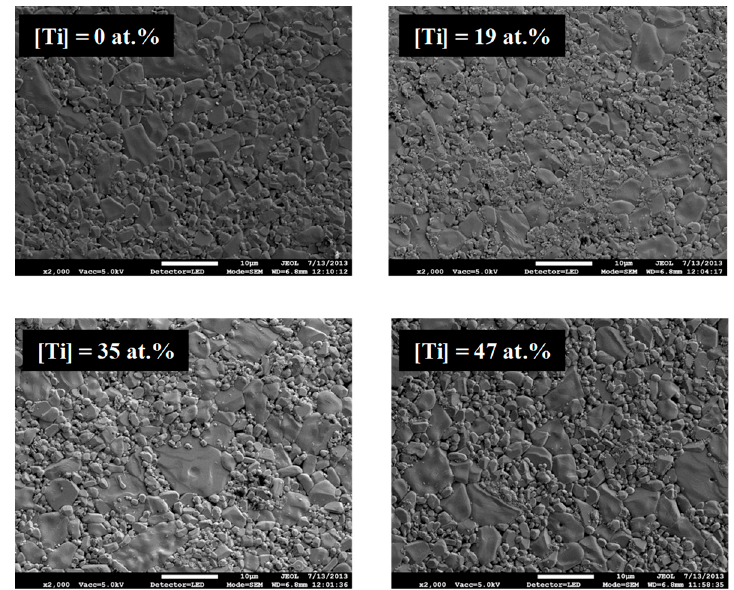
Figure 2. SEM observations of the top surface of Pt–Ti coatings with different Ti concentrations as-deposited on alumina pellets.